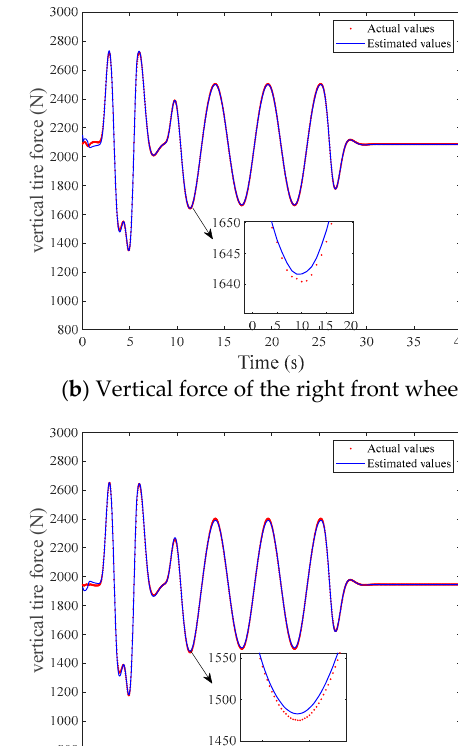
Figure 13. The lateral tire force of the wheels.